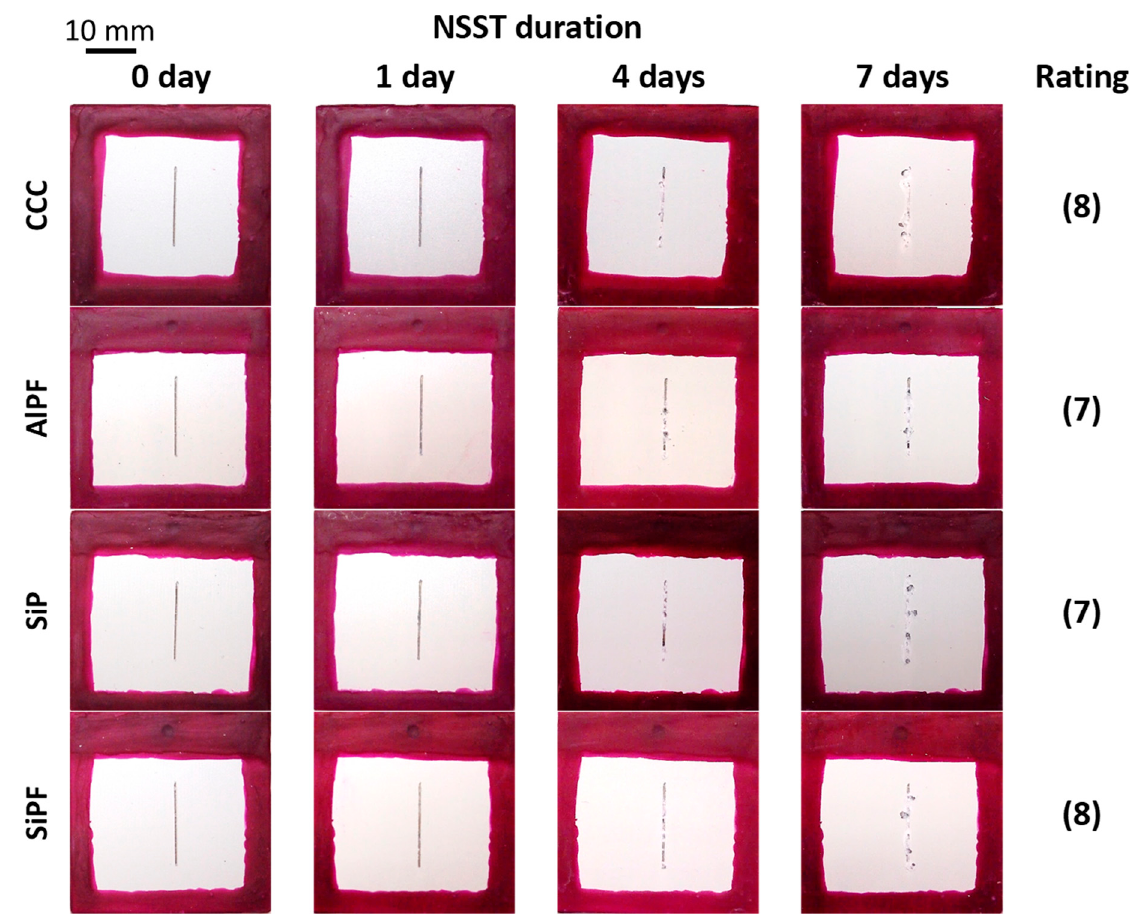
Figure 18. Salt spray testing results of Cr(VI)-based commercial coating and varied PEO covered with three-component epoxy primer, evaluated according to ASTM D 1654 standard